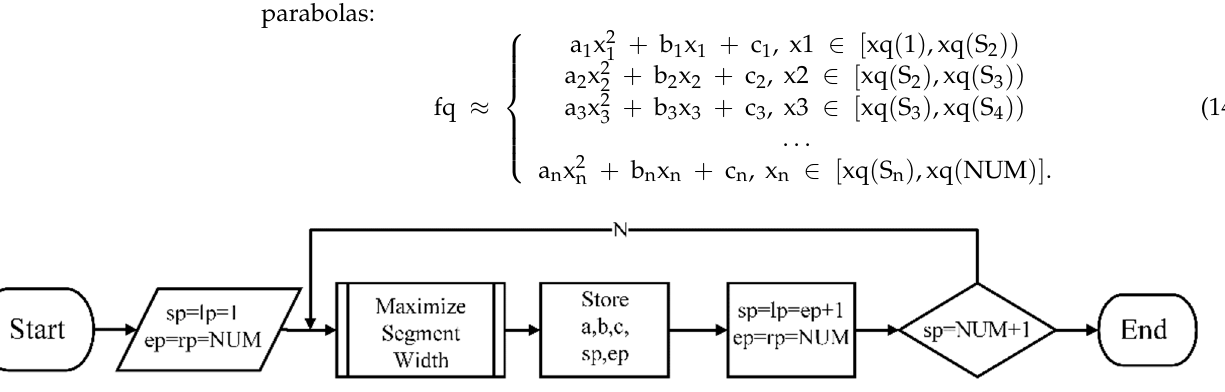
Figure 5. Error distribution of square root √x with 12 segments in [0, 1).